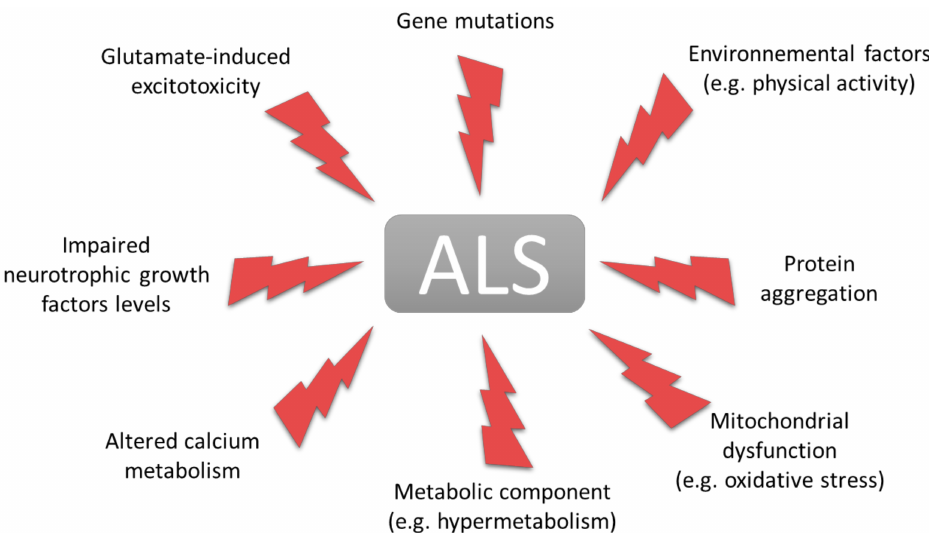
Figure 1. Pathogenic mechanisms thought to contribute to the development of ALS. Current data support several hypotheses that may explain the onset of ALS. Taken individually, these toxic events can mimic some of the hallmarks of ALS. This representation shows the complexity and multifactorial character of this